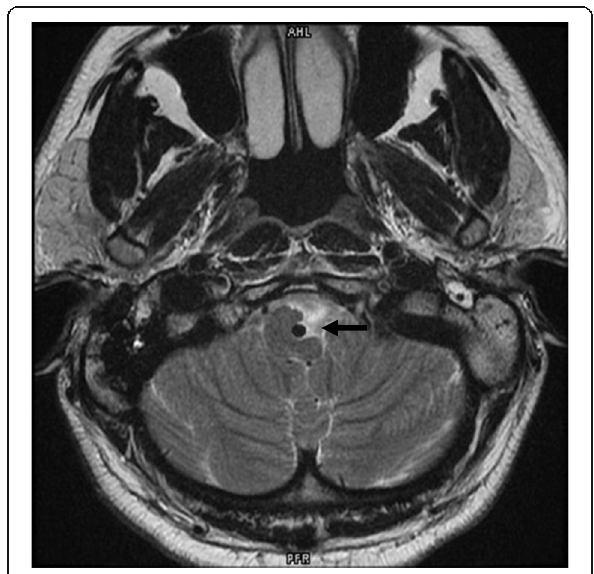
Fig. 1 Brain MRI of case (1) showed the VA compressing the lateral aspect of MO and displacing it to the contralateral side (kidney-shaped) “ arrow ”